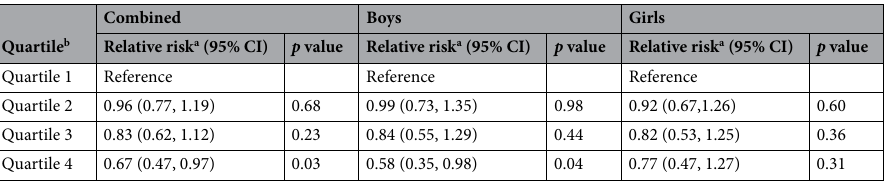
Table 3. Adjusted * relative risk (95% CI) for type 1 diabetes developed by age 16 years in children born in Western Australia between 1980–2014 by erythemal UVR during the third trimester. a Models adjusted for ethnicity, maternal age, maternal diabetes, birth weight, parity, IEO, IRSD, caesarean section, gestational age at time of birth and complications during pregnancy. b Total sum of UVR is divided into quartiles (IQ1, median IQ3). IQ1 was used as the reference category. Quartiles based on distribution in